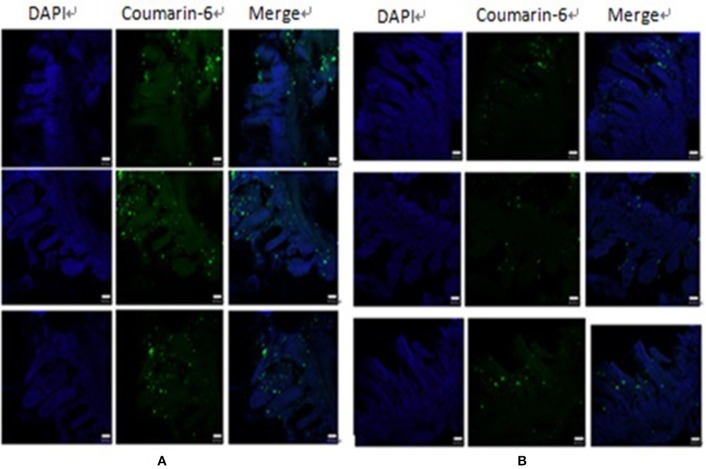
CLSM images of the effect of UEA-1 conjugation on M cell transport. UEA-1/PLGA-coumarin-6 NPs (A) and PLGA-coumarin-6 NPs (B) penetrated the intestine mainly in the PP.